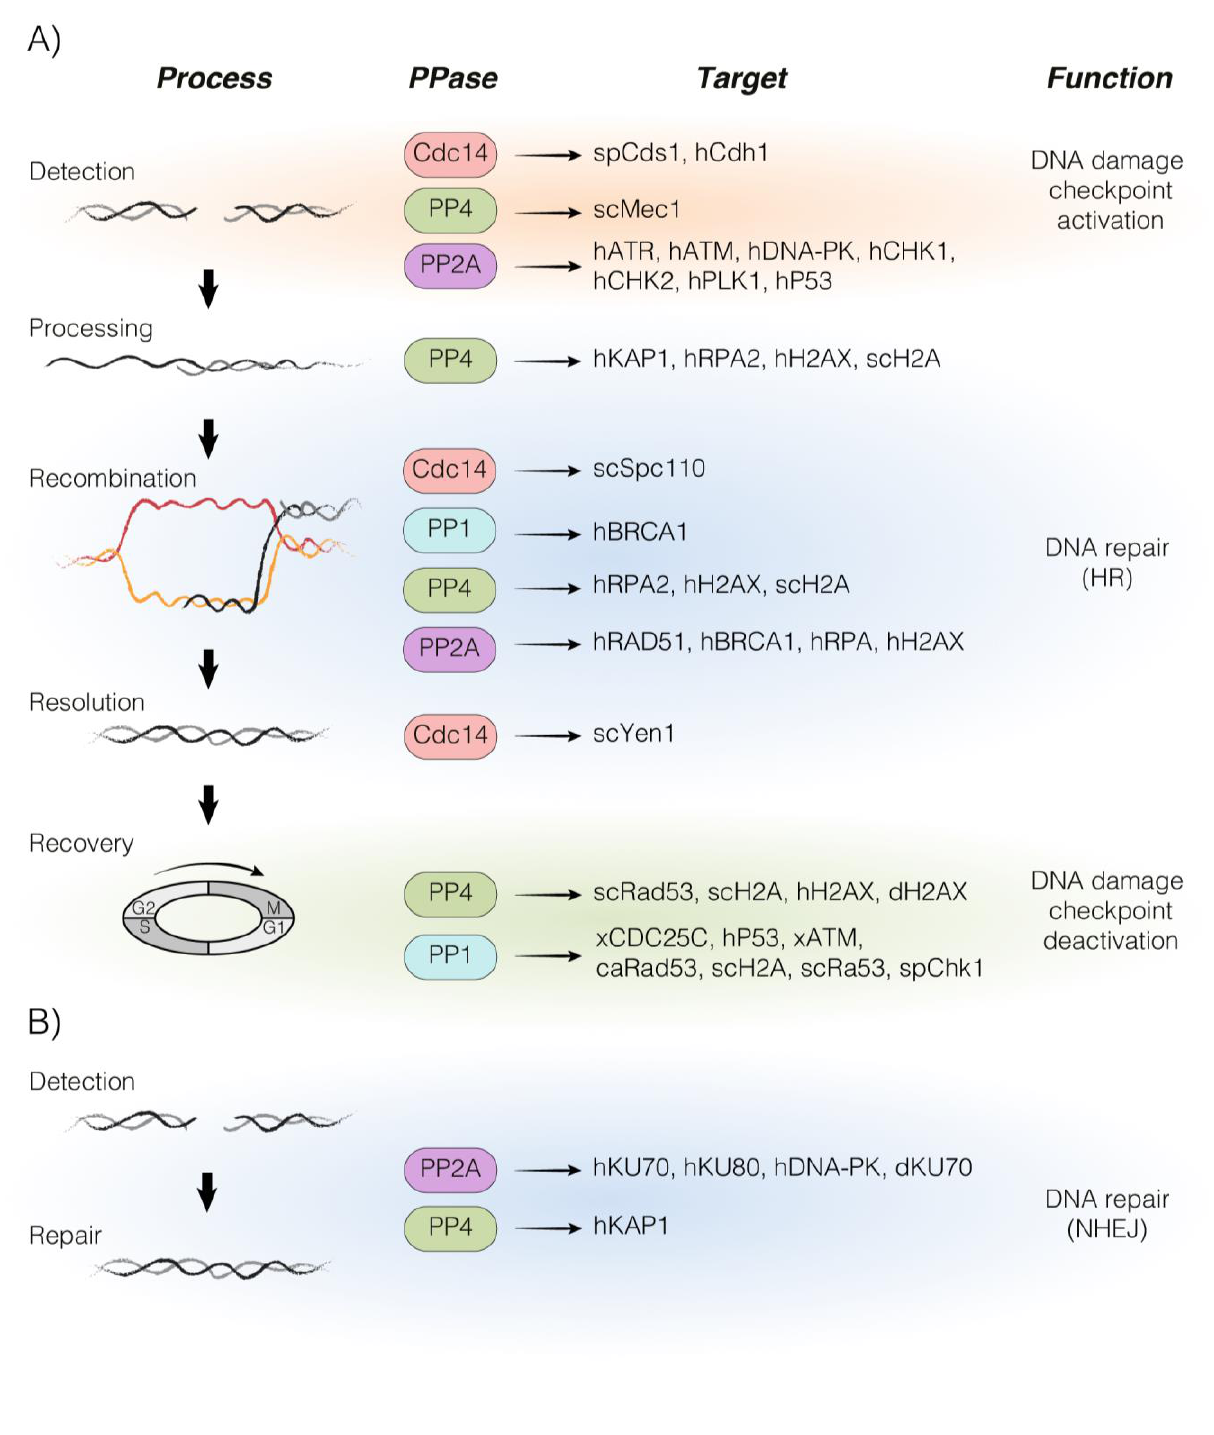
FIGURE 1: A global overview of the protein dephosphorylation landscape in the DDR. The figure summarizes the participation of PP1, PP2A, PP4 and Cdc14 in each step of the DNA damage response. All phosphatase´s targets identified in different model organisms are also depicted (sc, Saccharomyces cerevisae ; sp, Schizosaccharomyces pombe ; ca, Candida albicans ; d, Drosophila melanogaster ; x, Xenopus; h, Human). The involvement of each protein phosphatase in the homologous recombination (A) and non-homologous end joining (B) pathways is portrayed. HR – homologous recombination, NHEJ – non-homologous end